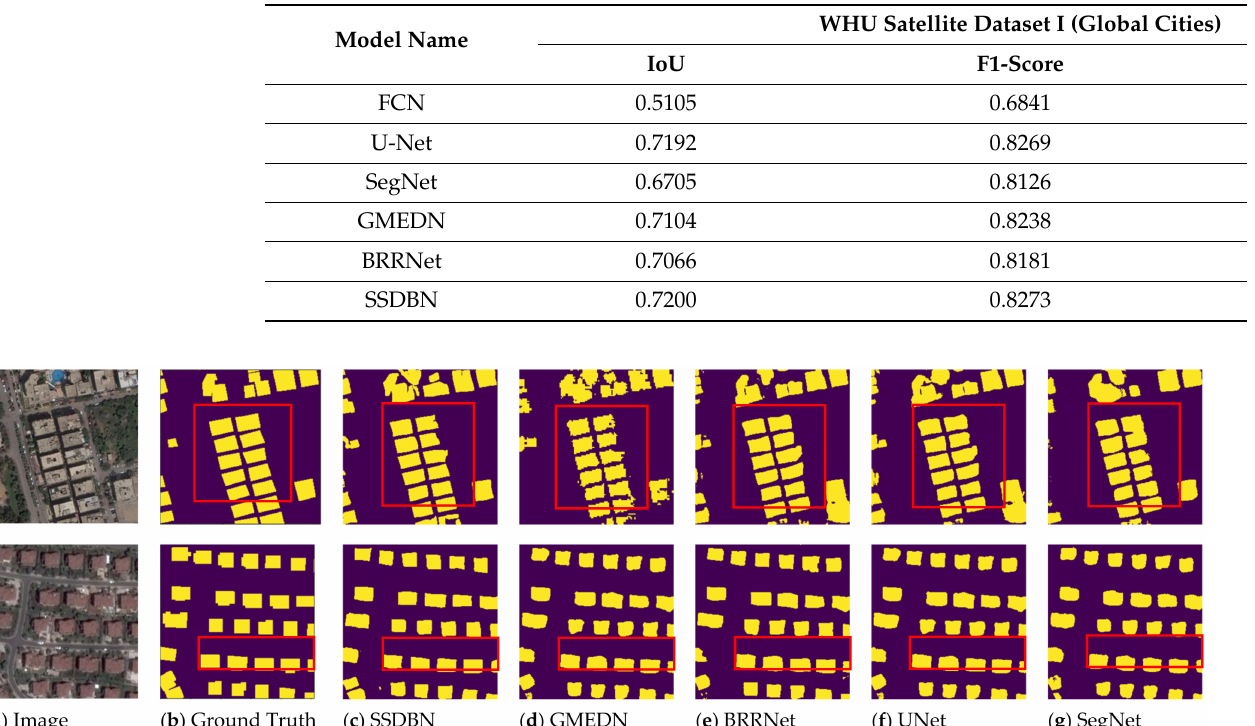
Table 4. Comparison of different models with the WHU Satellite Dataset I (global cities).